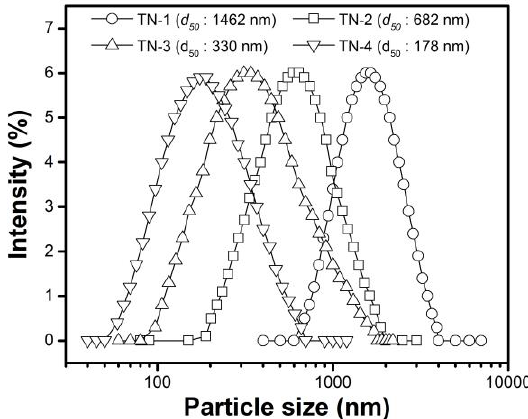
Figure 2. Size distribution of four types of talc nanoparticles detected by DLS.